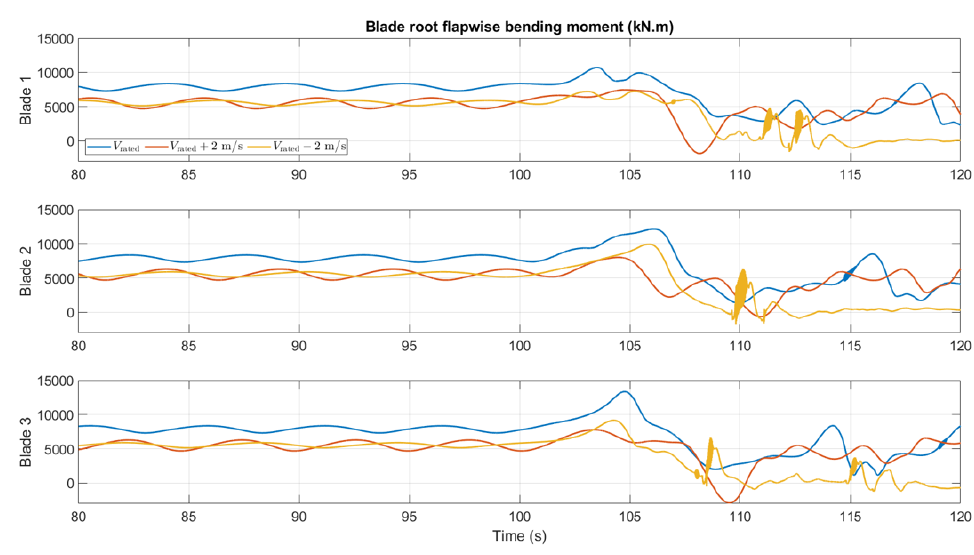
Figure 5. Blade root flapwise bending moments under three ECD wind